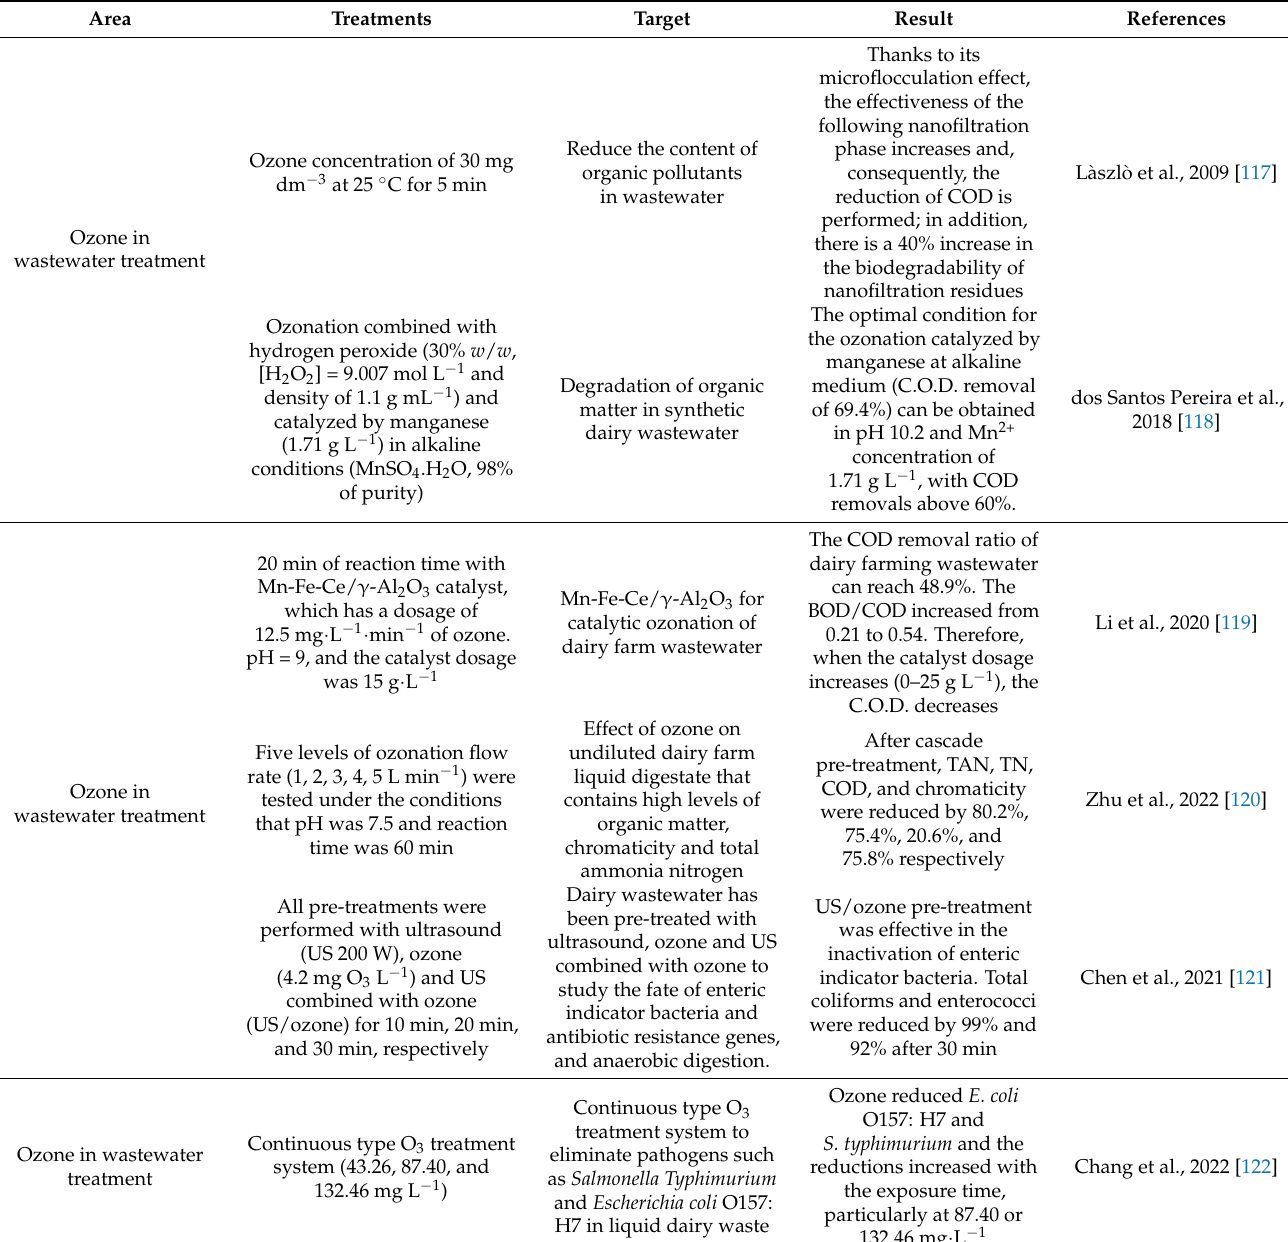
Table 5. Ozone for wastewater